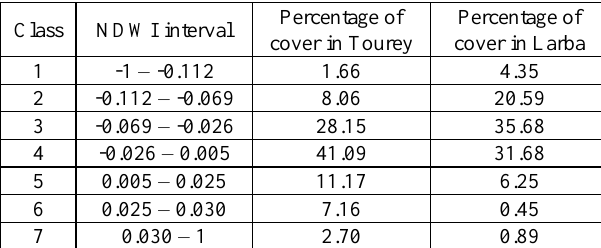
Table 9. Pixels distribution (percentage) of the NDWI raster within the identified classification. Column one shows the name of the class, column two the interval of values describing the class (low value ≤ DN < higher value), in column three are reported the percentage of cover of each class The results obtained from the NDWI were visually check against the data collected with the SONY ILCE camera.